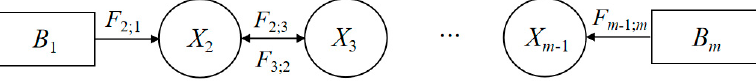
Figure 1. A typical DUCG model.